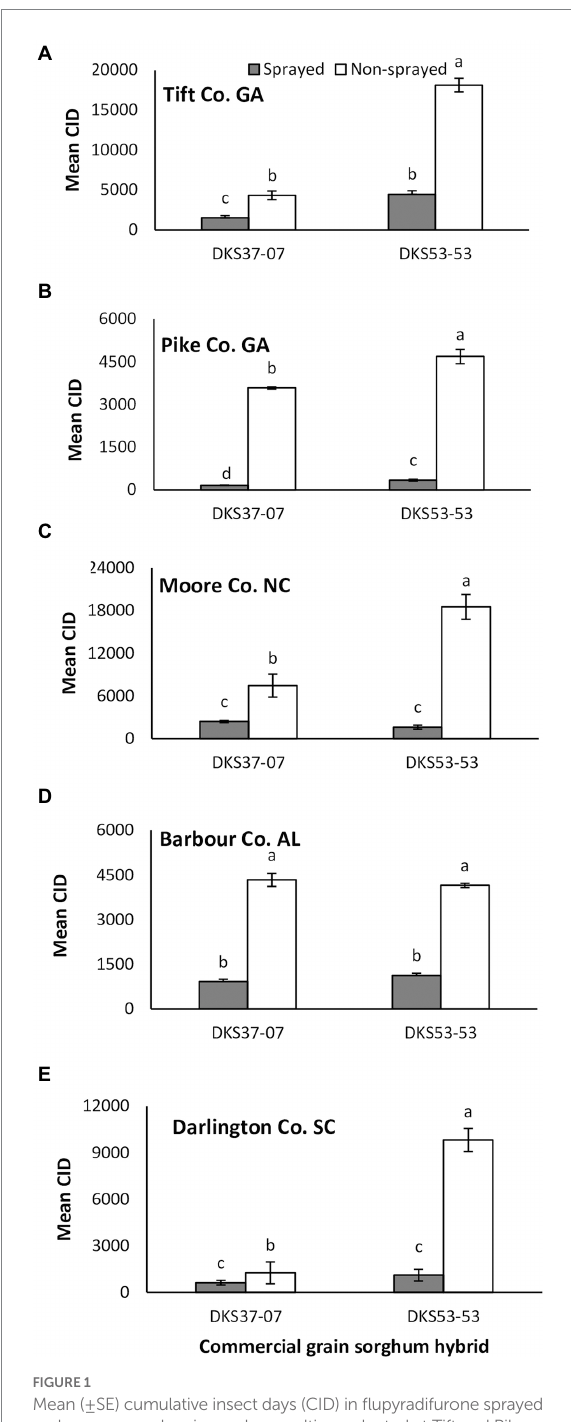
FIGURE 1 Mean (±SE) cumulative insect days (CID) in flupyradifurone sprayed and non-sprayed grain sorghum cultivars planted at Tift and Pike Co. GA, Moore Co. NC, Barbour Co. AL and Darlington Co., SC in 2018. Means capped with different letters are significantly different (sequential Bonferroni test, p < 0.05) among all four treatments. Note that y-axis scales are different on each figure.